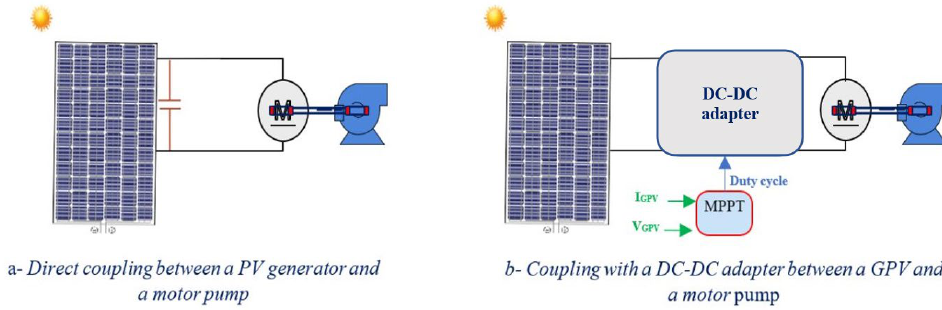
Figure 1. Coupling types between the motor pump and the GPV.